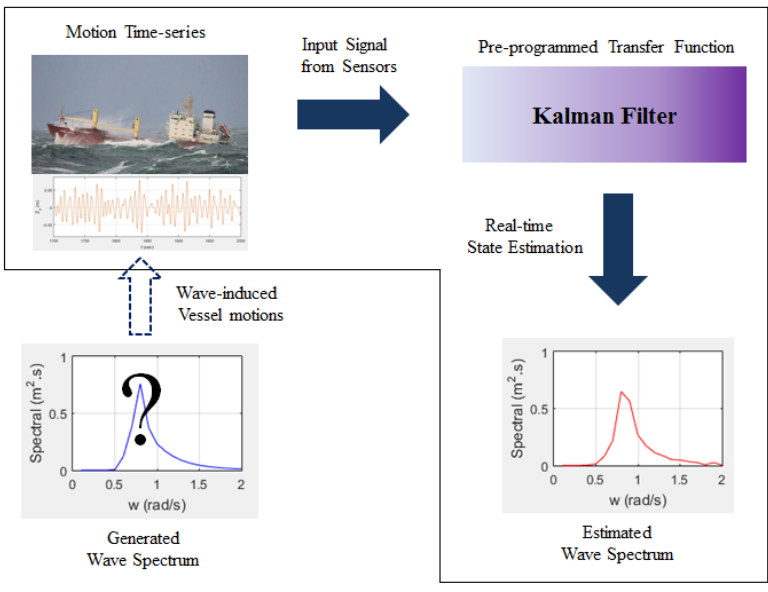
Figure 1. Wave spectrum estimation process using Kalman filter.